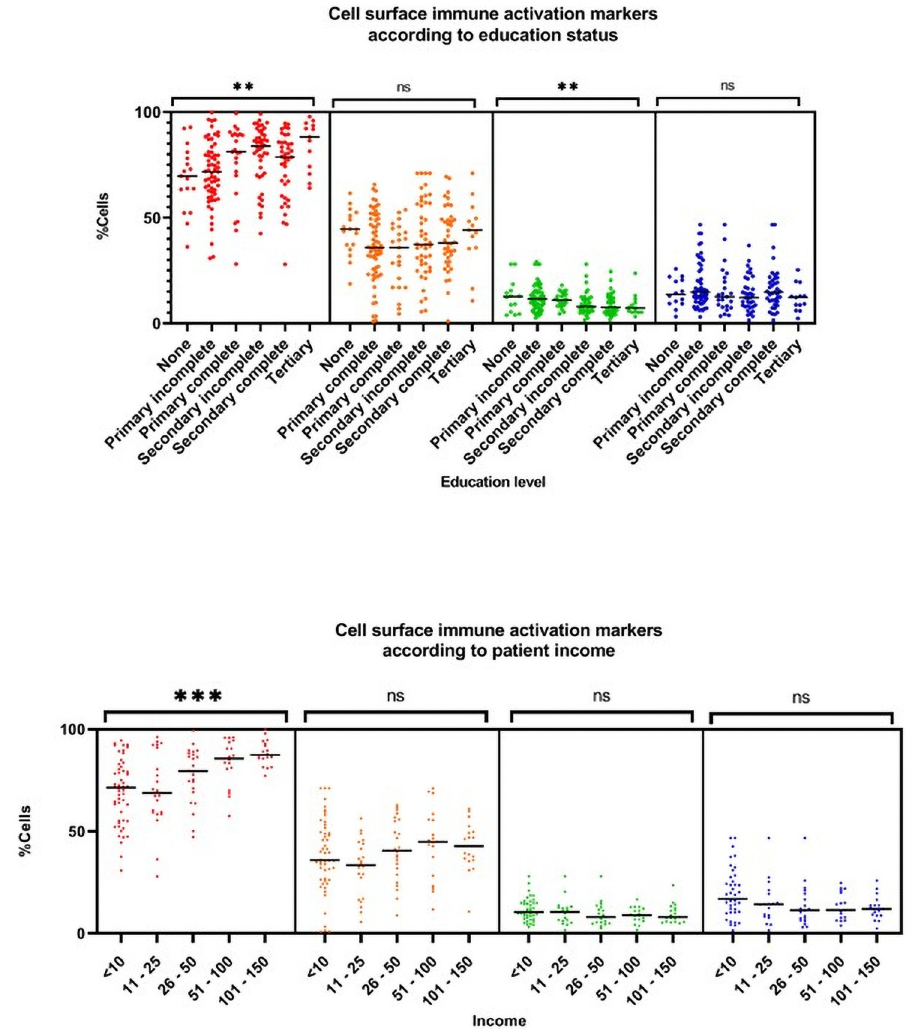
Fig 1. Cell surface immune activation markers according to education and income category. � p < 0.01 �� p > 0.001 ��� p < 0.0001 ns p >